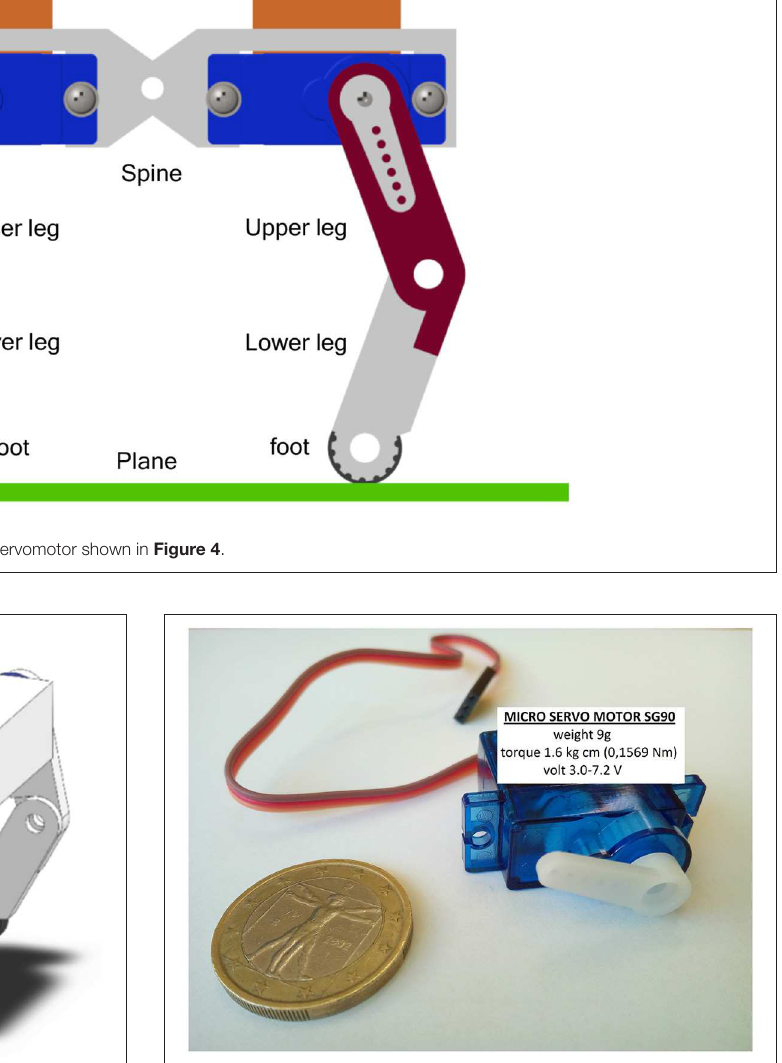
FIGURE 3 | Robot virtual model.